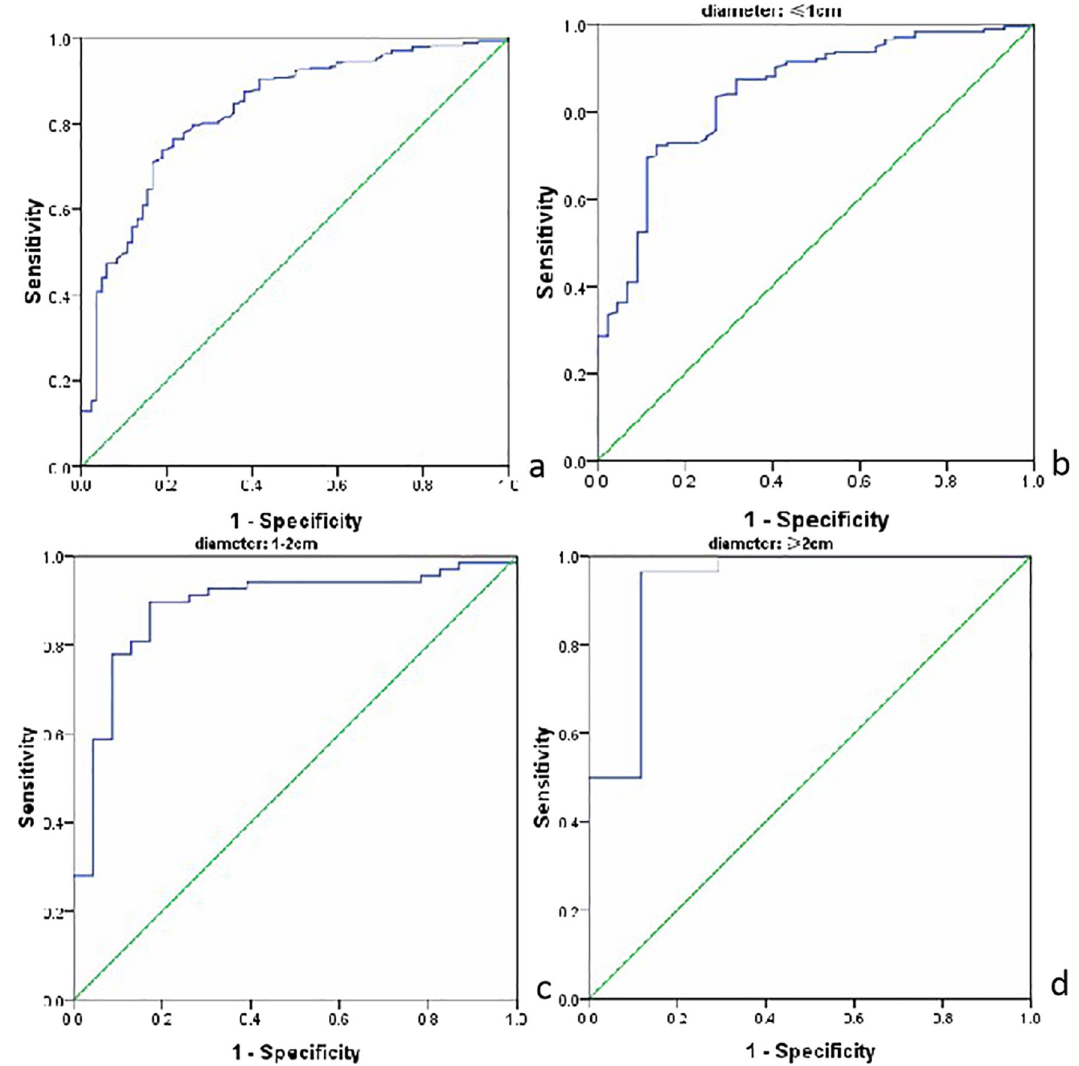
Figure 1. ROC curves to evaluate the efficacy of Emax in the diagnosis of malignant thyroid nodules before and after grouping. ( a ) ROC curve of entire dataset. ( b ) ROC curve of Group A. ( c ) ROC curve of Group B. ( d ) ROC curve of Group C. The figure was created by R software(version 3.4.4, url: https:// www.R- proje ct.